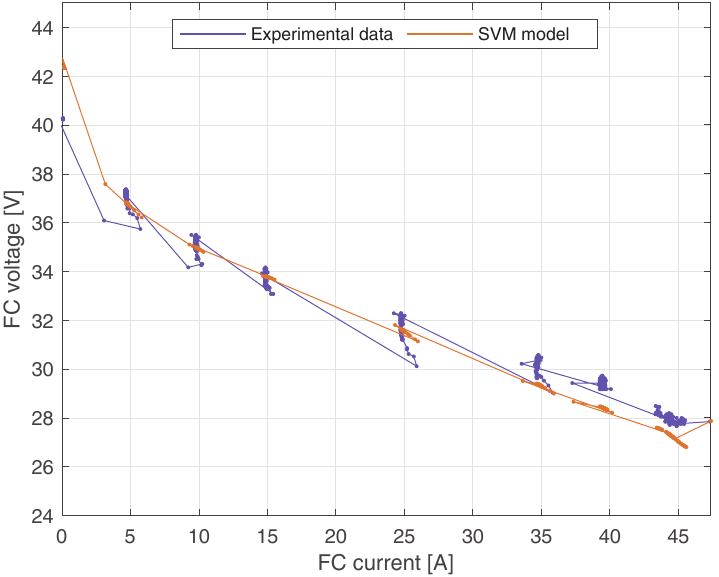
Figure 11. Dynamic V-I characteristic of the PEMFC obtained with real and estimated FC voltage using the SVM model, from the second profile of the FC load